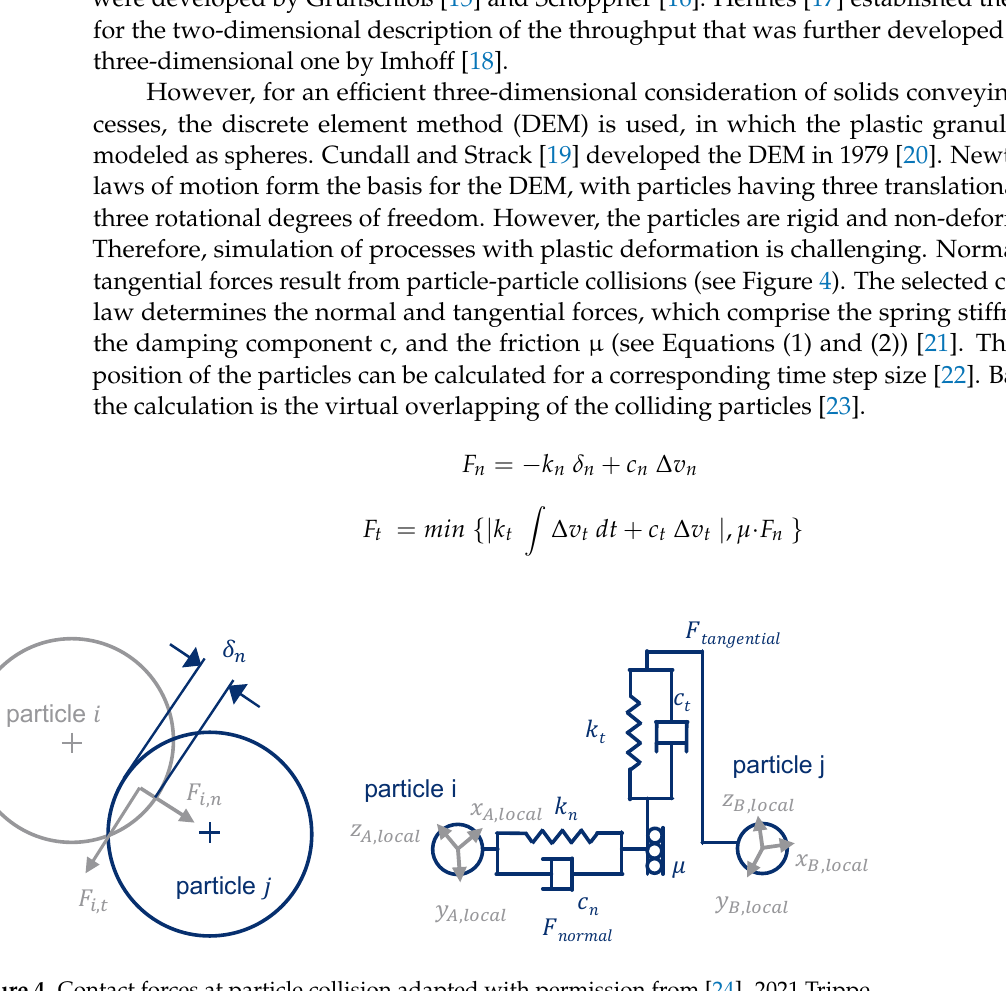
Figure 4. Contact forces at particle collision adapted with permission from [24]. 2021 Trippe.